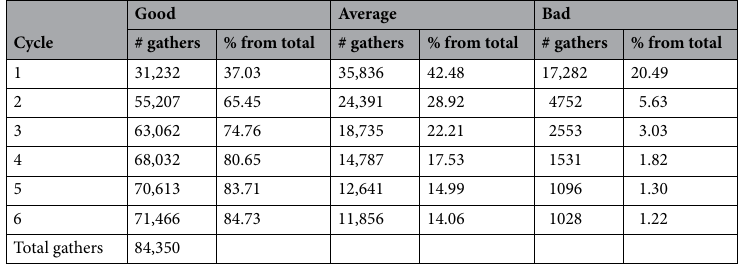
Table 2. Number of gathers in each group considering the complete QC score (updated in every cycle) for experiment DS2. The numbers are also given as percentages from the total number of gathers.